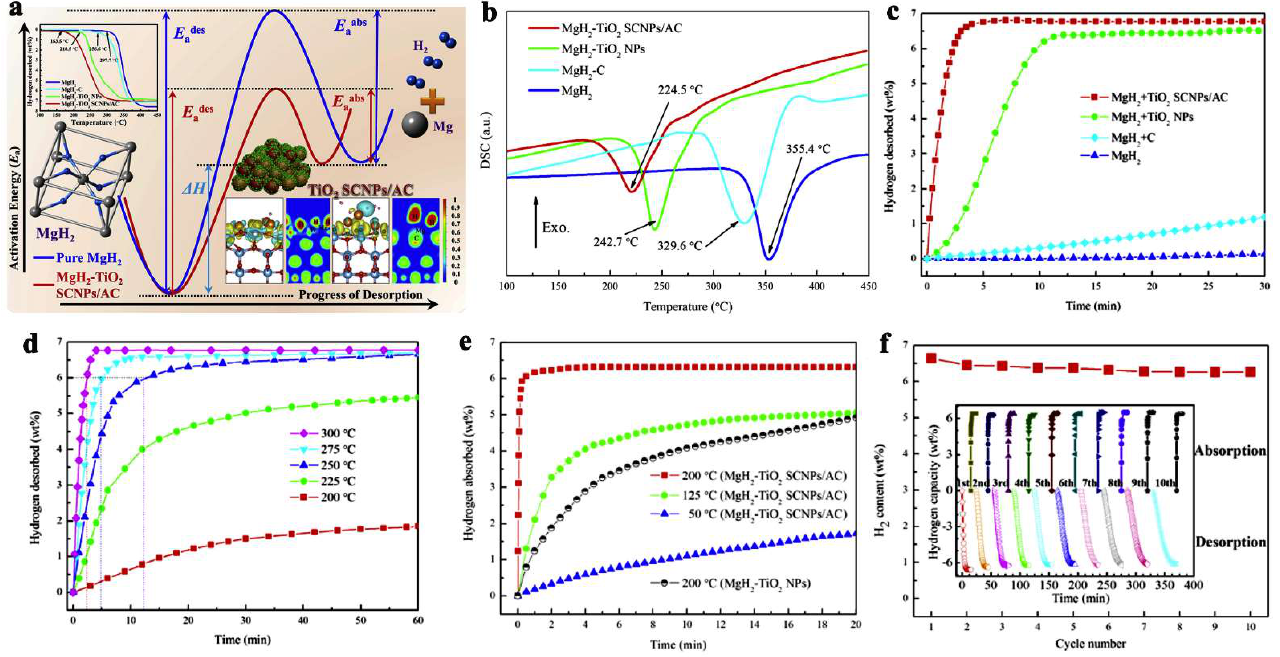
Figure 7. Schematic mechanistic approach in catalytic behavior of MgH 2 -TiO 2 SCNPs/AC ( a ). DSC ( b ) of the investigated samples: ball-milled MgH 2 , MgH 2 -C, MgH 2 -TiO 2 NPs and MgH 2 -TiO 2 SCNPs/AC. Isothermal desorption curves of the four investigated samples at 300 °C ( c ); Isothermal desorption curves of MgH 2 -TiO 2 SCNPs/AC and MgH 2 -TiO 2 NPs at various temperatures in the range 50…300 °C ( d ), ( e ); confirmation of reversible hydrogen storage capacity of MgH 2 -TiO 2 SCNPs/AC at 300 °C recharging pressure of 50 bar H 2 ( f ). Reprinted/adapted with permission from Ref. [95]. 2019, Elsevier.